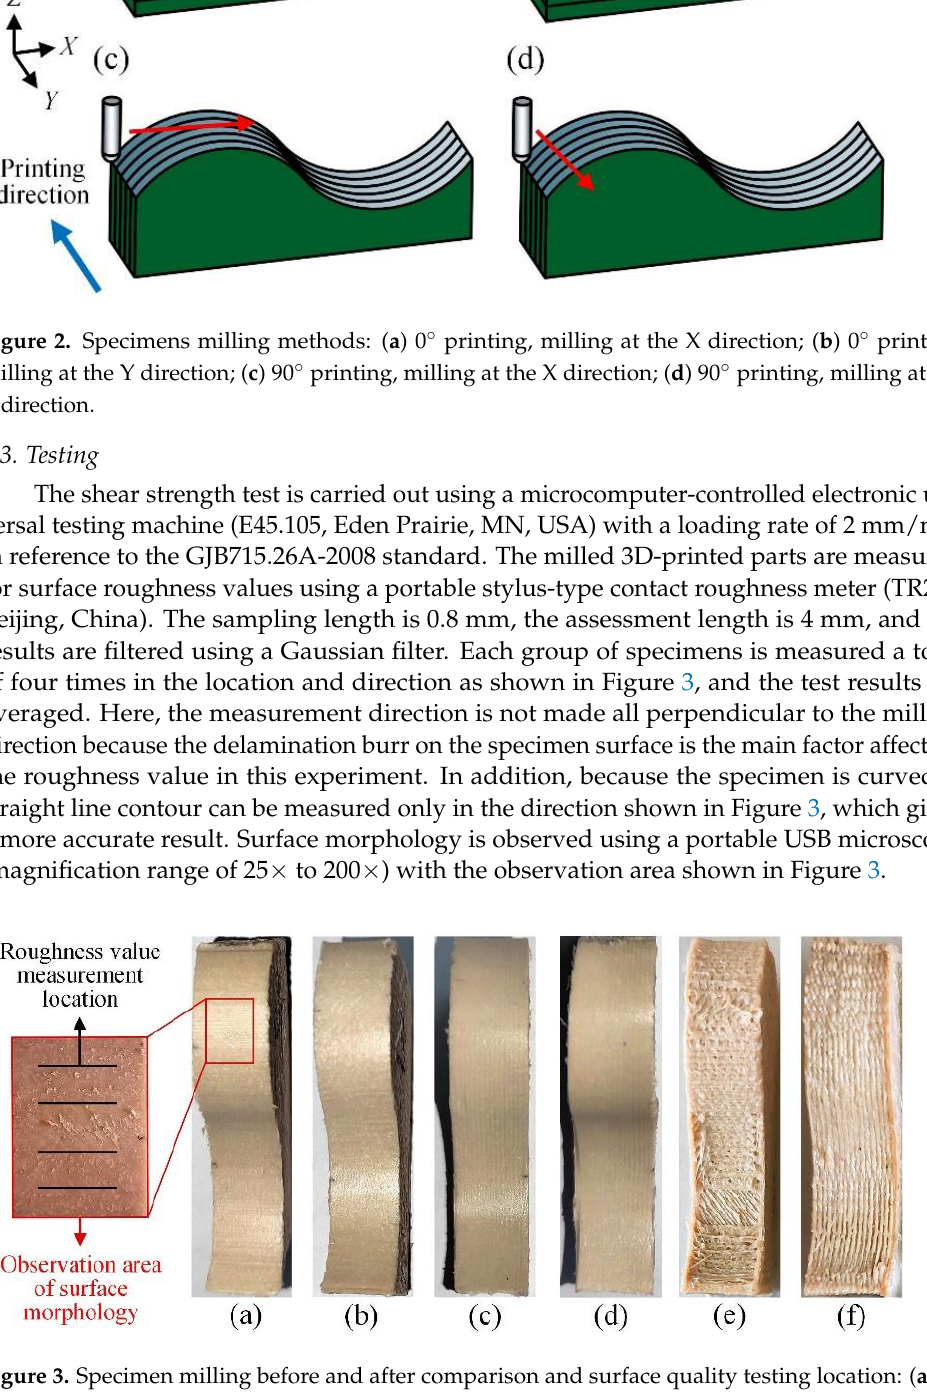
Figure 3. Specimen milling before and after comparison and surface quality testing location: ( a ) 0 ◦ printing, milling at the X direction; ( b ) 0 ◦ printing, milling at the Y direction; ( c ) 90 ◦ printing, milling at the X direction; ( d ) 90 ◦ printing, milling at the Y direction; ( e ) 0 ◦ printing; ( f ) 90 ◦